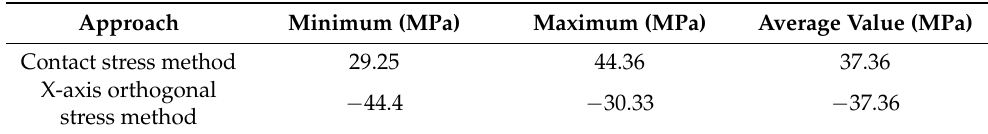
Table 7. SolidWorks simulation data